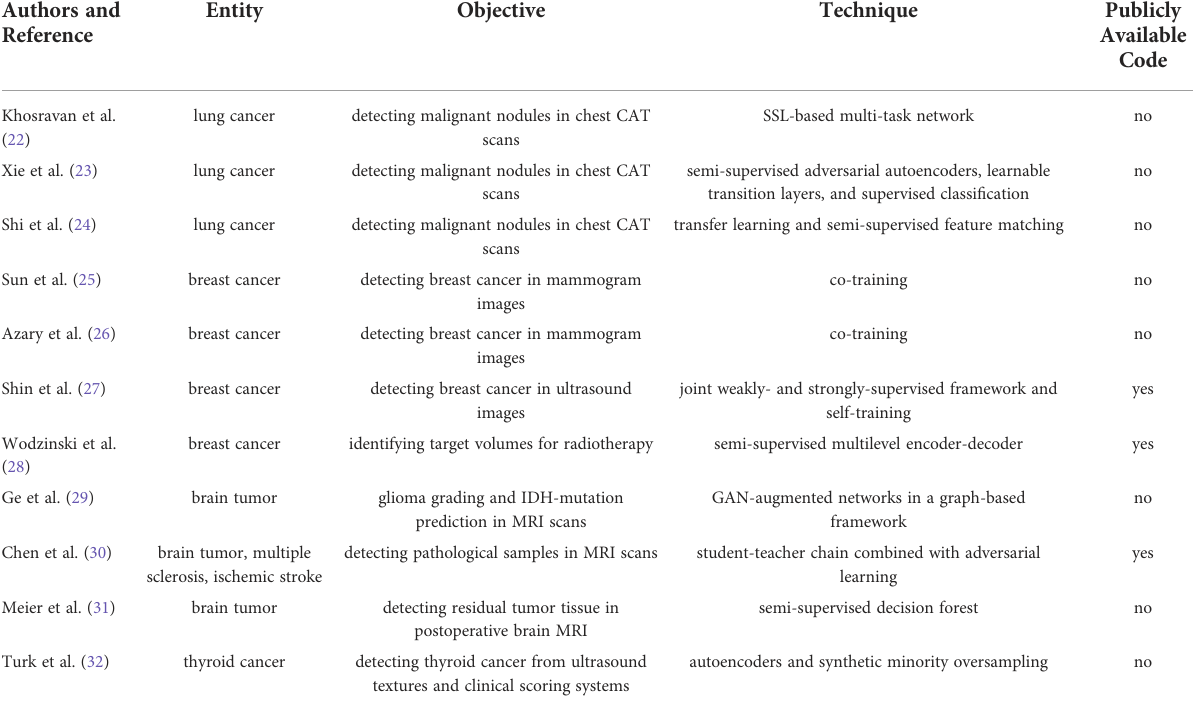
TABLE 2 Overview of Studies on Semi-Supervised Learning in Radiology and Radiotherapy. Authors and